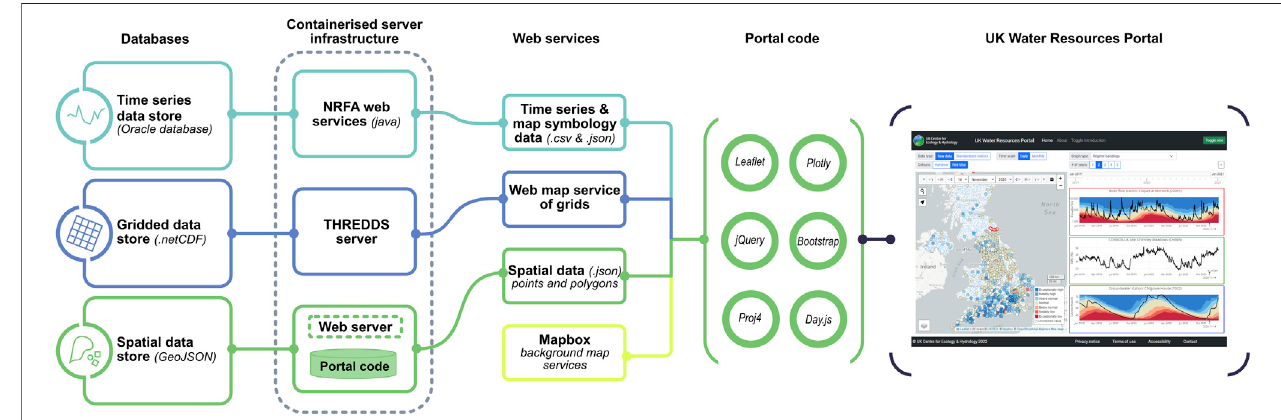
FIGURE 5 | Infrastructure, processes and libraries used to build the UK Water Resources